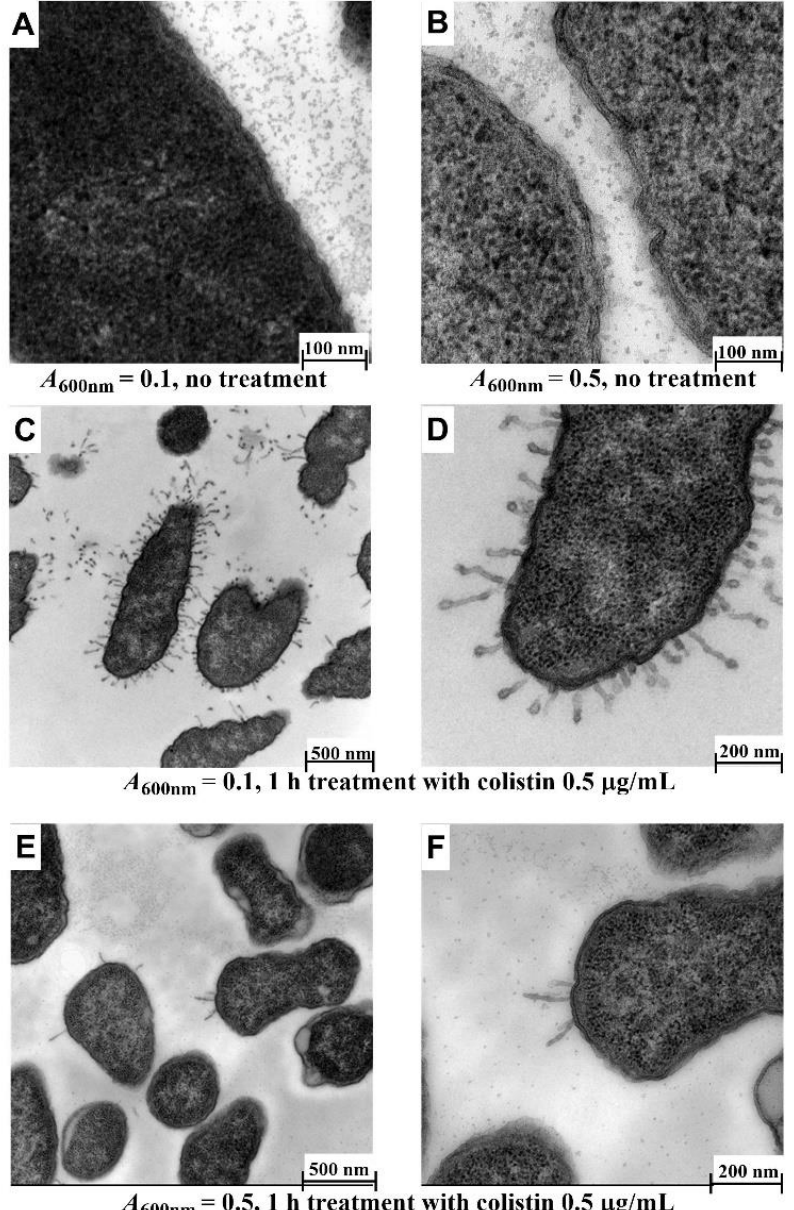
Figure 5. Effect of cell density on morphology of Xen14 cells after treatment with colistin at 0.5 µ g/mL for 1 h. ( A , B ) Untreated cells; ( C , D ) cells grown to A 600nm = 0.1; ( E , F ) cells grown to A 600nm = 0.5. Cacodylate buffer and fixative containing 4.0% formaldehyde, 1.25% glutaraldehyde, 4% sucrose and 0.01 M CaCl 2 was used and embedded in Epon